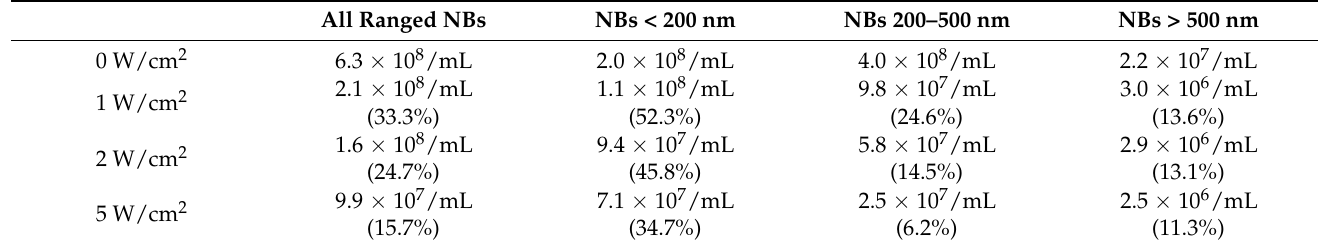
Table A2. Changes in the concentration of regenerated nanobubbles with sonication.